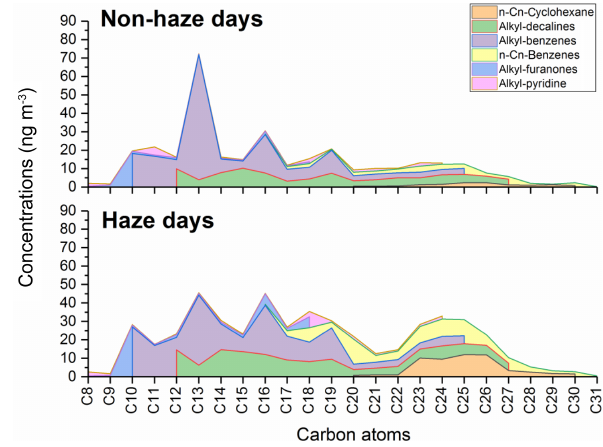
Figure 5. The molecular distributions of n-C n -cyclohexane, alkyl- bicyclic-alkanes, alkyl-benzenes, n-C n -benzenes, alkyl-furanones and alkyl-pyridines on haze and non-haze days.